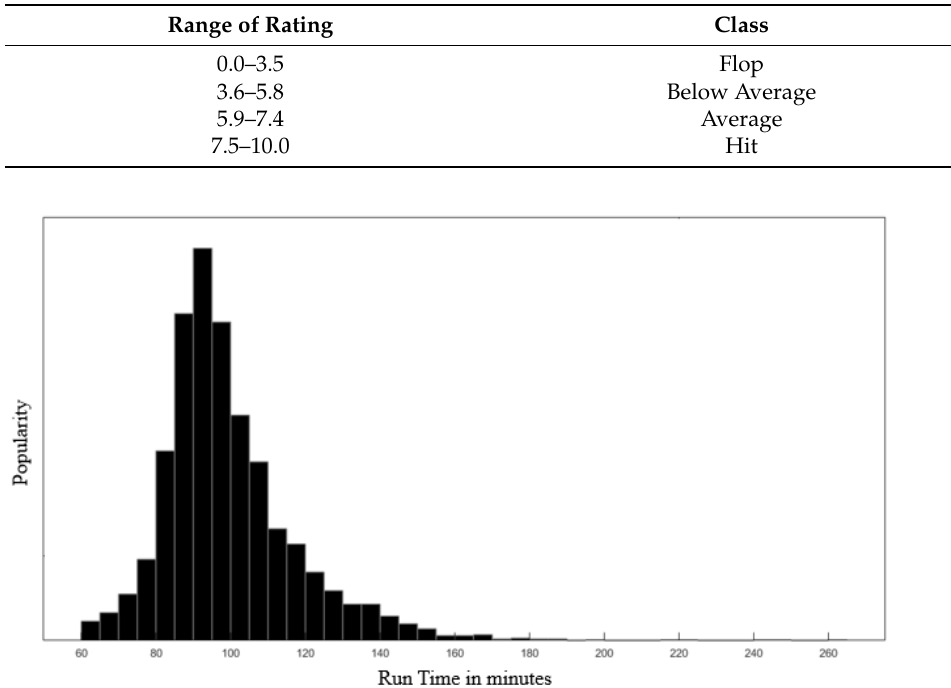
Figure 2. Relationship between Run Time in Minutes and Popularity.